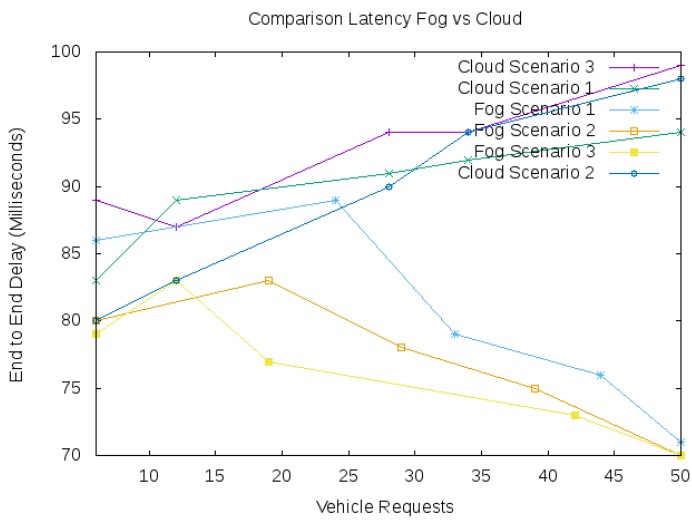
Figure 6. Comparison of latency: fog vs. cloud.